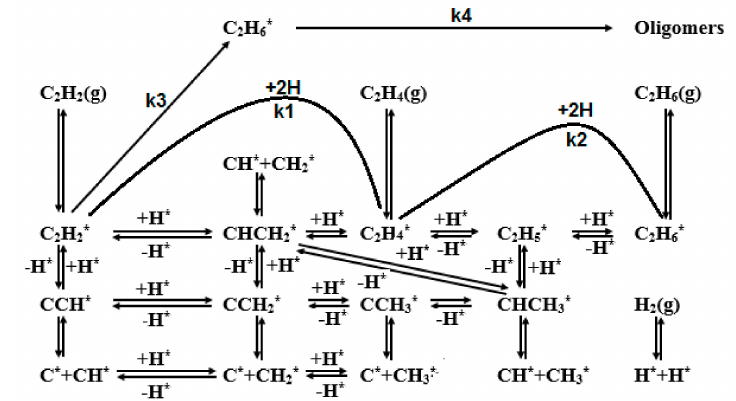
Figure 1. Selective and unselective reaction pathways for acetylene